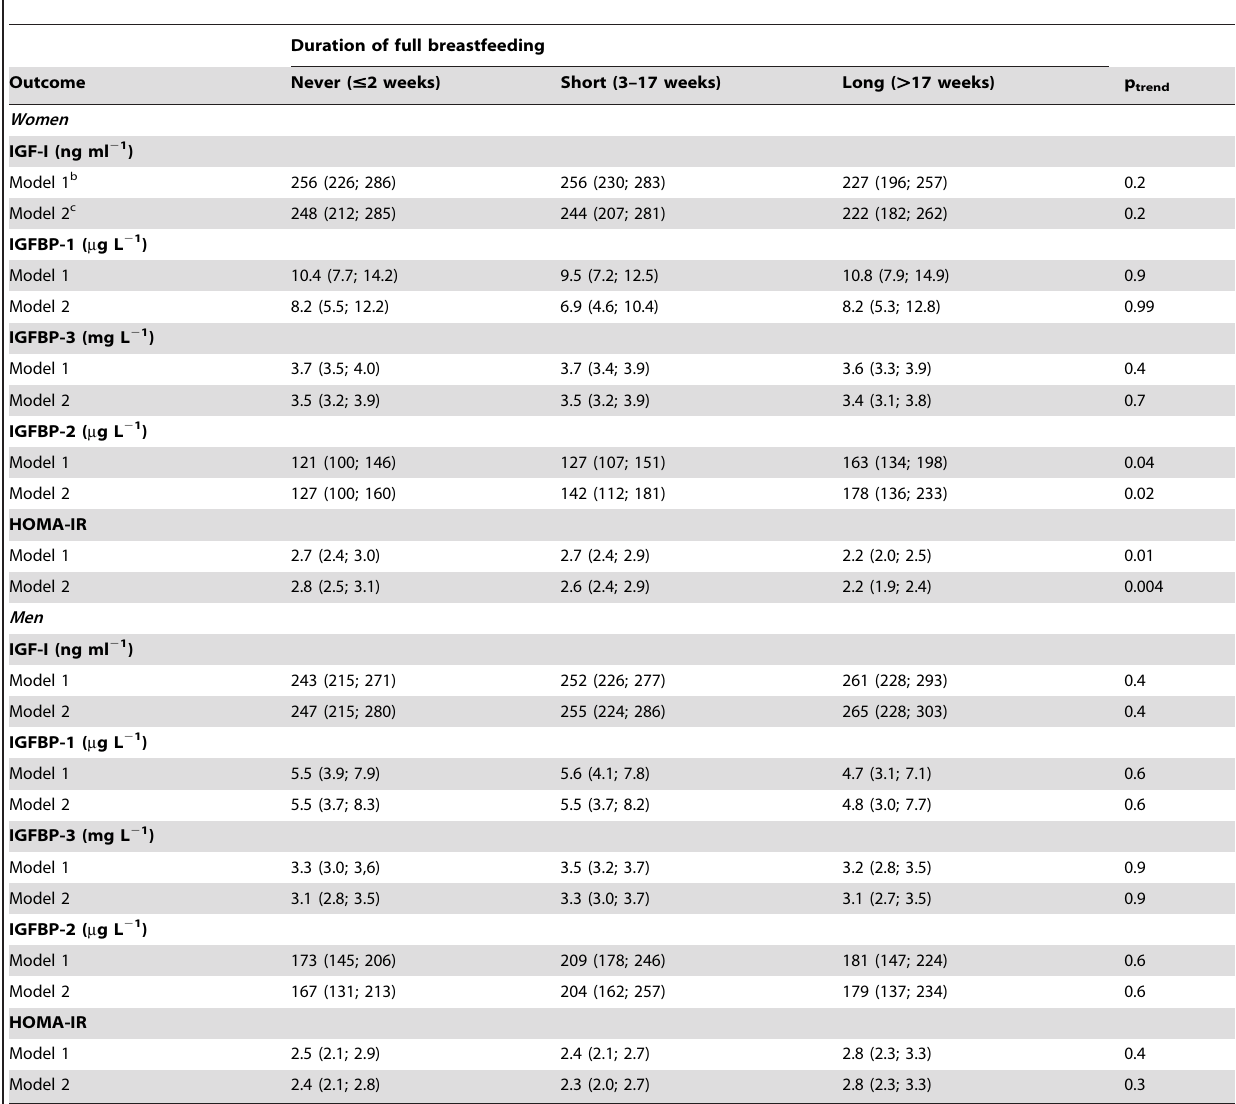
Table 2. Components of the GH-IGF-axis and insulin sensitivity in young adulthood according to breastfeeding status in infancy, DONALD Study (n= 122–125 women, 107–108 men) a